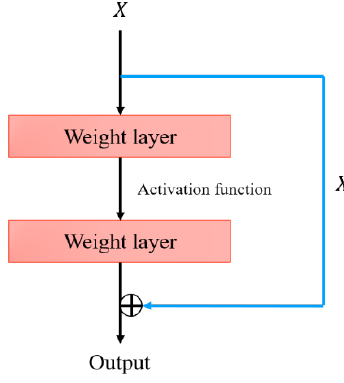
Figure 1. Structure of building block.